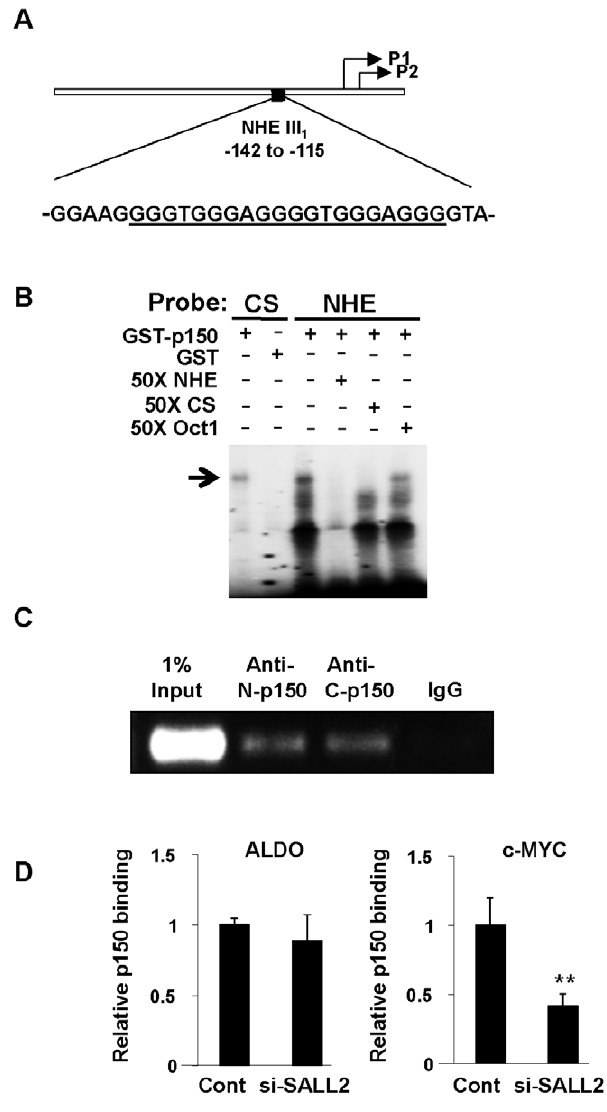
Figure 1. GST-p150 binds to the c-MYC promoter region invitro and invivo . (A) The GC-rich nuclease hypersensitive element NHE III 1 of the human c-MYC promoter. Consensus binding sites for p150 are underlined. Approximate positions of transcriptional start sites are shown (P1, P2). (B) An electrophoretic mobility shift assay shows binding of GST-p150 to the labeled NHE III 1 and to the consensus binding sequence (CS) GGGTGGG- as control ( ). 50 6 molar excess of unlabeled NHE III 1 and CS compete for binding while the unrelated Oct1 olionucleotide does not. (C) Chromatin immunoprecipitation assays with antibodies to the N- and C-terminal portions of p150 show binding of endogenous p150 to the NHE III 1 region of the c-MYC promoter in HOSE cells. (D) SALL2-knockdown leads to reduced binding of p150 to the c-MYC promoter. HOSE cells were treated with SALL2 siRNA or control oligonucleotide and followed by chromatin immuno- precipitation and quantitative RT-PCR assays. The threshold cycle values of immunoprecipitates were normalized to those of 1% input control samples. The human aldolase A promoter region was included as a negative control. Estimates of binding were based on triplicate samples. ** denotes p , 0.01 based on Student t test run on HOSE cells treated with SALL2-siRNA or control